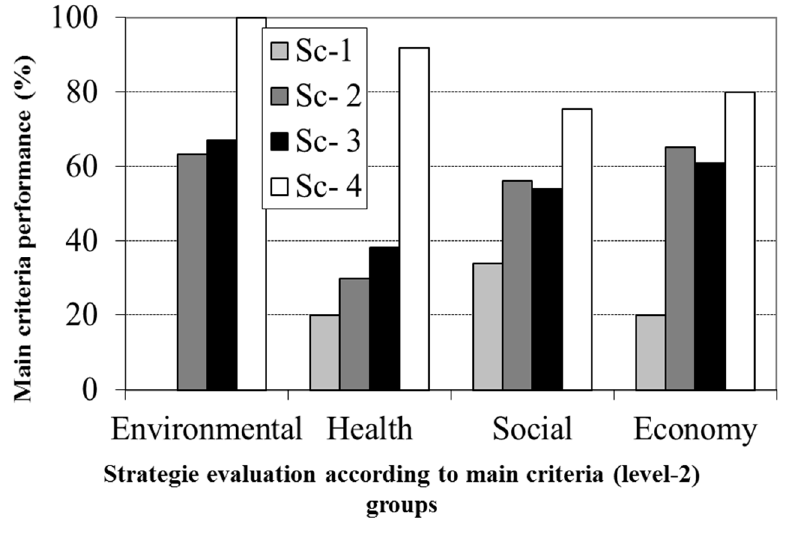
Figure 8. Ranking of the strategies according to main criteria group (level 2) using AHP-WLC